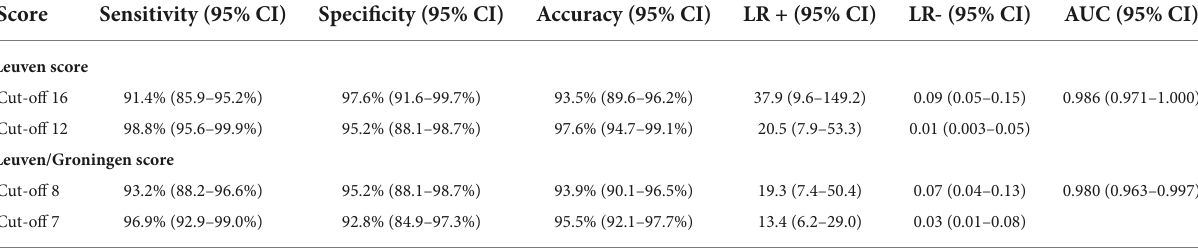
TABLE 2 Diagnostic accuracy of Leuven and Leuven/Groningen